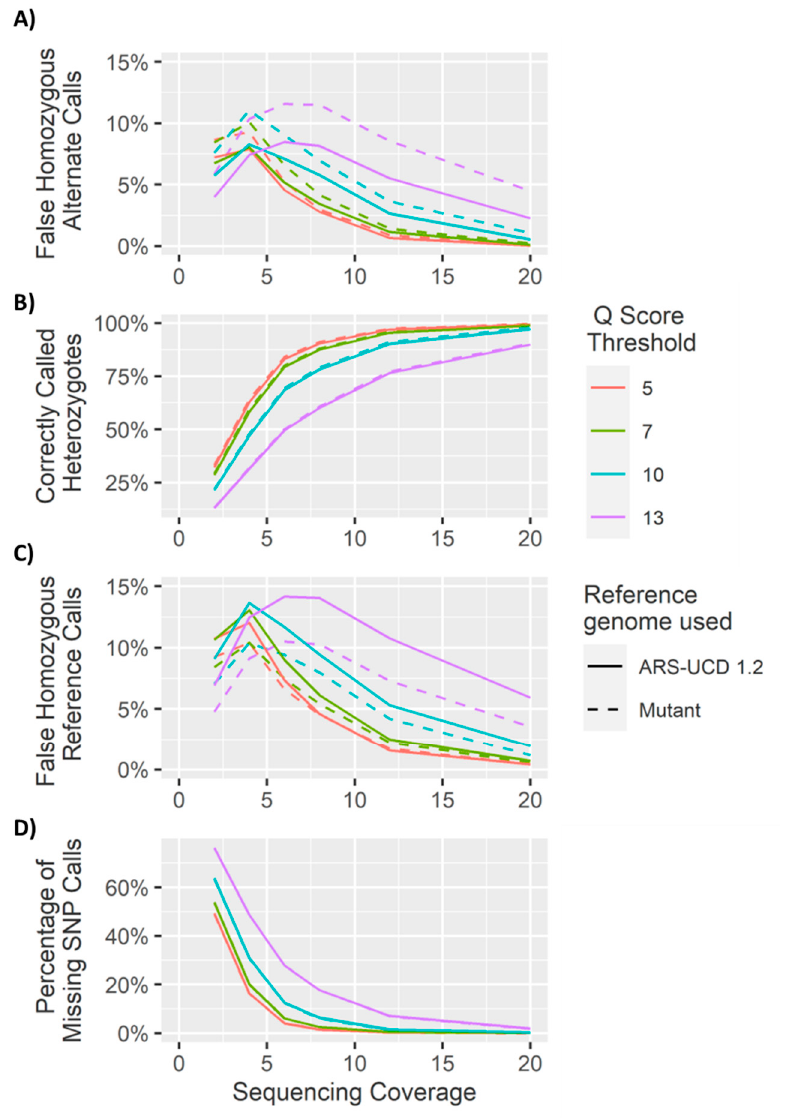
Figure 7. Genotype calling results from the alignments to chromosome 28 of ARS-UCD 1.2 and to the mutant chromosome at the 10,000 heterozygous sites. ( A ) The percentage of SNPs correctly identified (heterozygous). ( B ) The percentage of false homozygous alternate calls. ( C ) The percentage of false homozygous reference calls. ( D ) The percentage of SNP loci with coverage less than 2×.